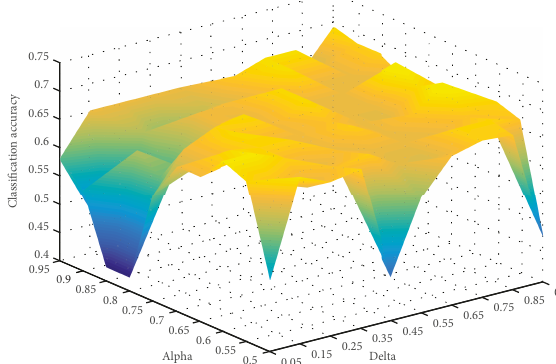
Figure 1: Classi fi cation accuracy with δ and α on